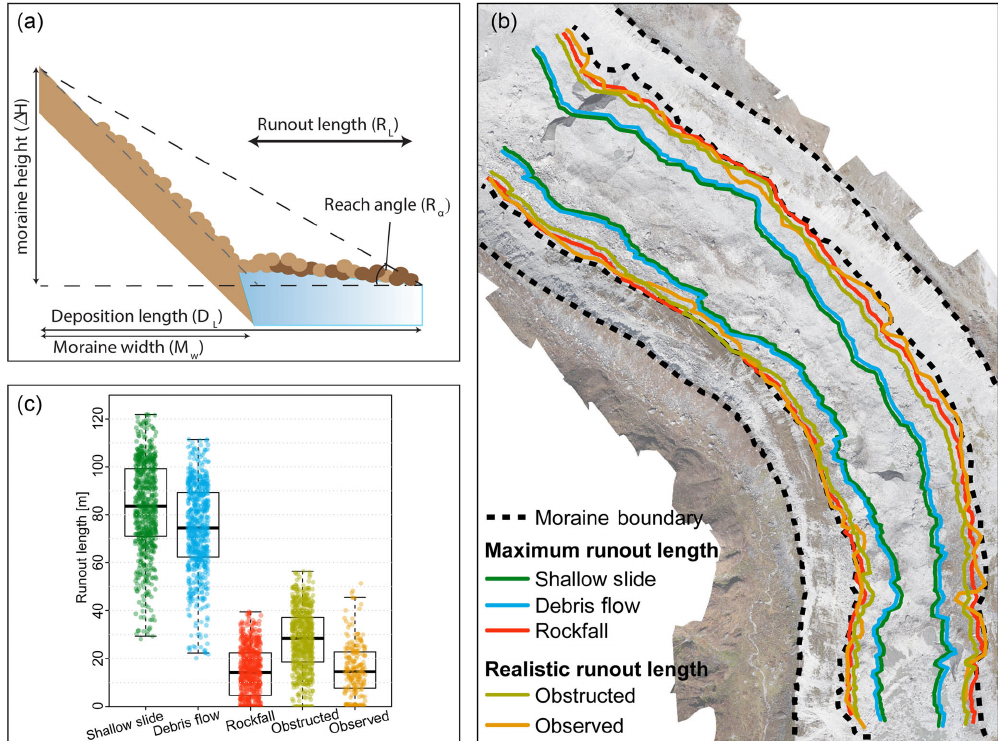
Figure 9. Conceptual diagram of model approach (a) , the modelled runout lengths (b) and the modelled variability in runout lengths (c)